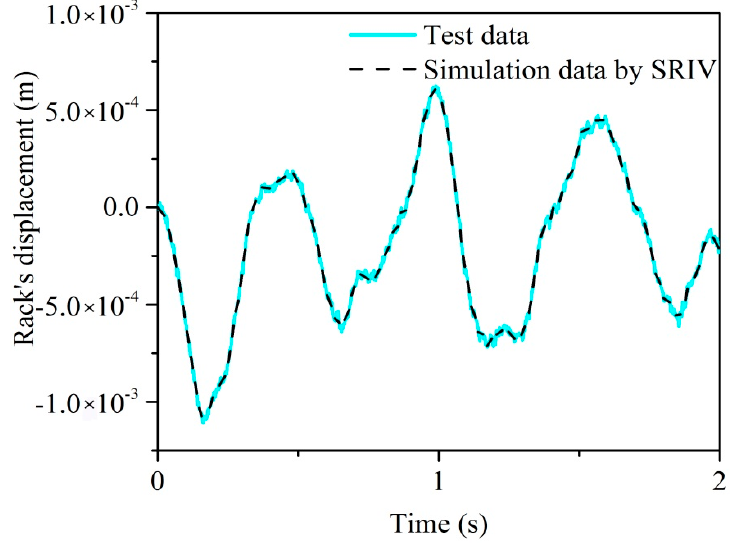
Figure 17. Comparison of the SRIV simulation data and test data.